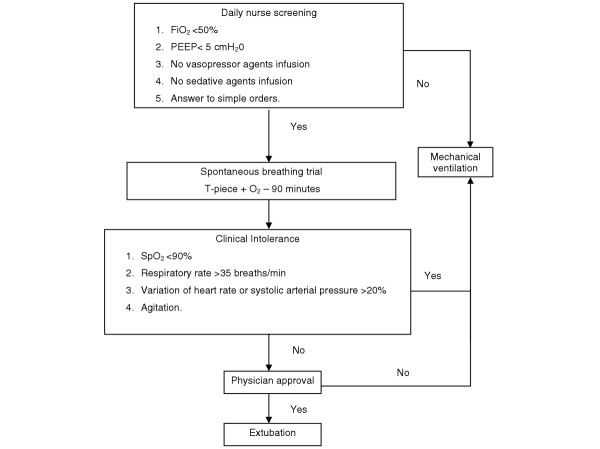
Mechanical ventilation weaning protocol. Daily nurse screening identified patients eligible for weaning. A spontaneous breathing trial was considered to be successful when the patient could breathe spontaneously for 90 min without clinical intolerance. For such patients, physicians were then asked to approve discontinuation of mechanical ventilation. If the spontaneous breathing trial was not tolerated, then the patient was returned to their prior ventilator settings and screened the day after. FiO2, fractional inspired oxygen; PEEP, positive end-expiratory pressure; SpO2, pulse oximetry.